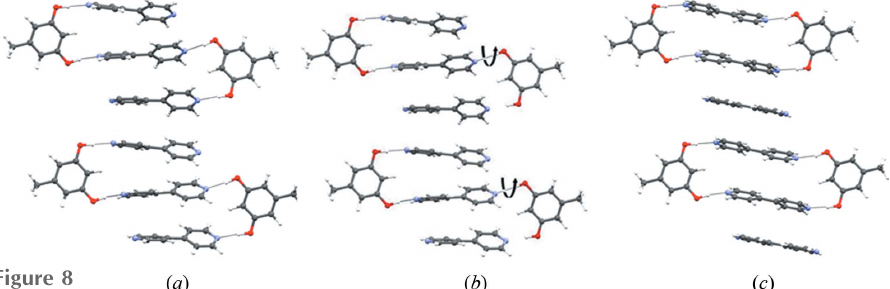
Figure 8 ( a ) Finite divergent arrangement (synthon A ) of molecules in form I . ( b ) Possible rearrangement of molecules during the course of crystallization. ( c ) Finite convergent arrangement (synthon B ) of molecules in forms II through to V